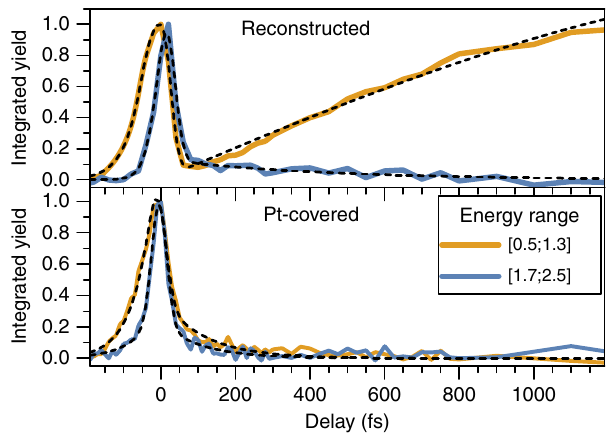
Fig. 3 Integrated electron yield of the reconstructed (top) and Pt-deposited (bottom) samples for two different spectral regions. Fits (black, dashed) were obtained by using exponential decay or biexponential rise models convoluted with a symmetric Gaussian shape to account for the instrument response. The asymmetry at negative time delays resulting from the temporal evolution of an initially hot electron distribution relaxing toward the conduction band minimum was added to the fi t. Source data are provided as a Source Data fi